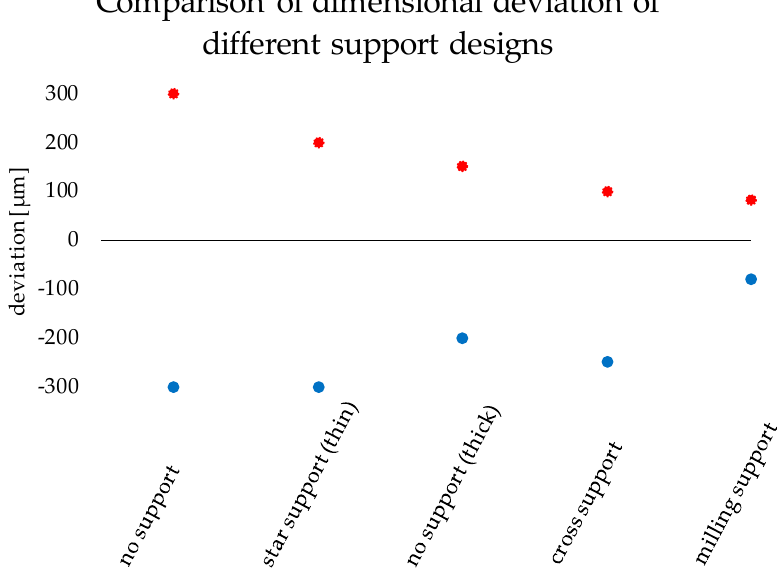
Figure 8. Comparison of 3D surface model (sintered molar crown with ‘milling’ support, design C) and stl file using GOM Inspect.